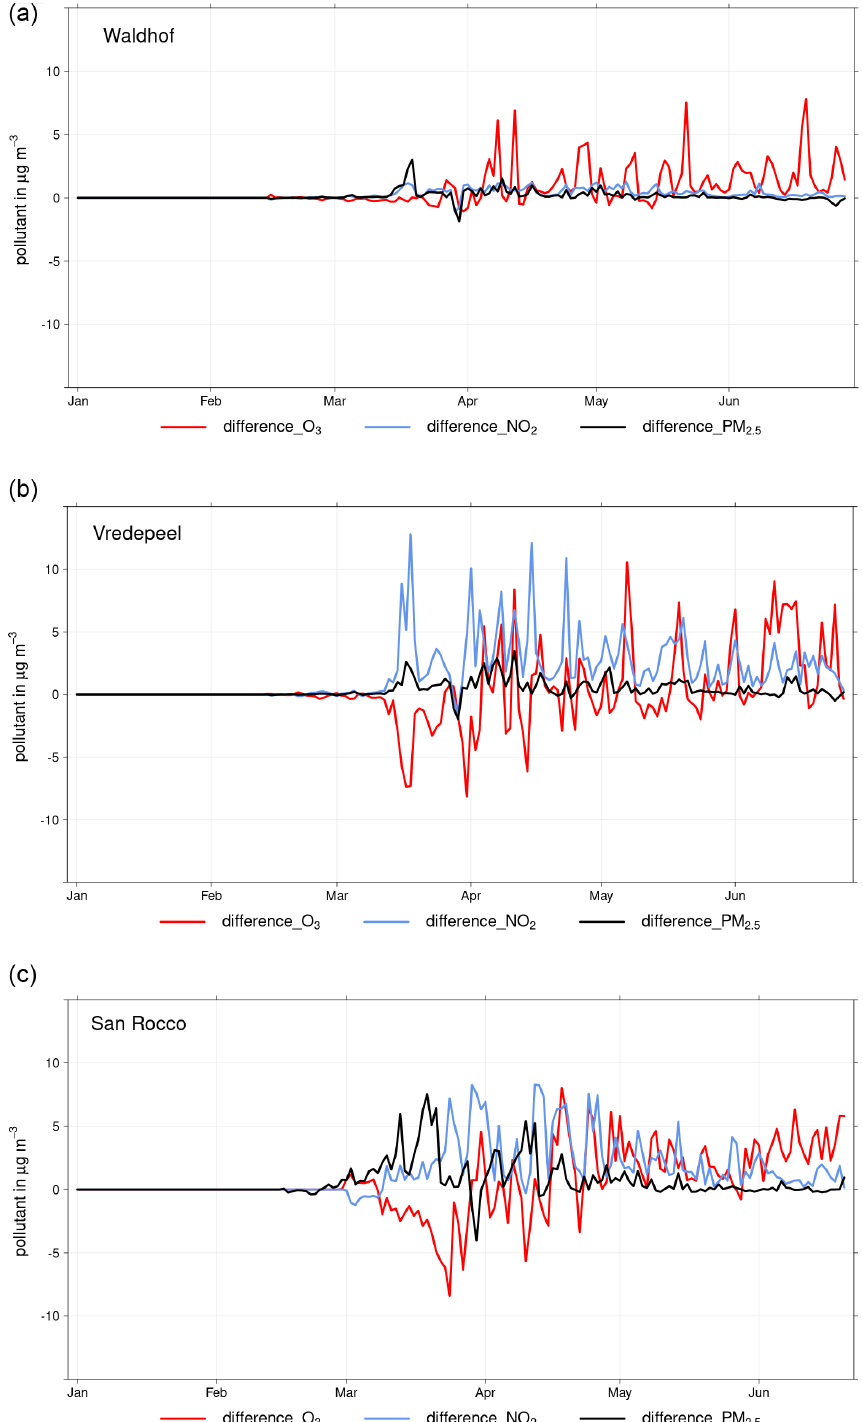
Figure 14. Temporal development of the differences in the simulated concentrations of O 3 (red), NO 2 (blue) and PM 2 . 5 (black) in Wald- hof (a) , Vredepeel (b) and San Rocco (c) between 1 January and 30 June